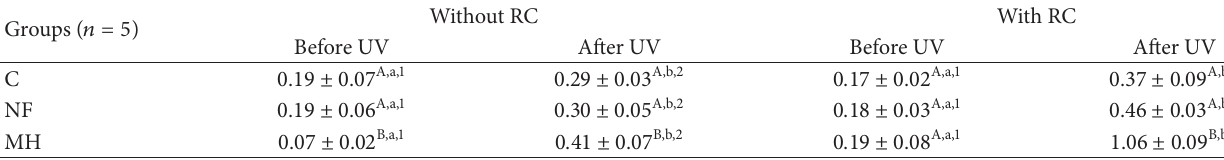
Table 3: Surface roughness (Ra) values of the groups (mean ±